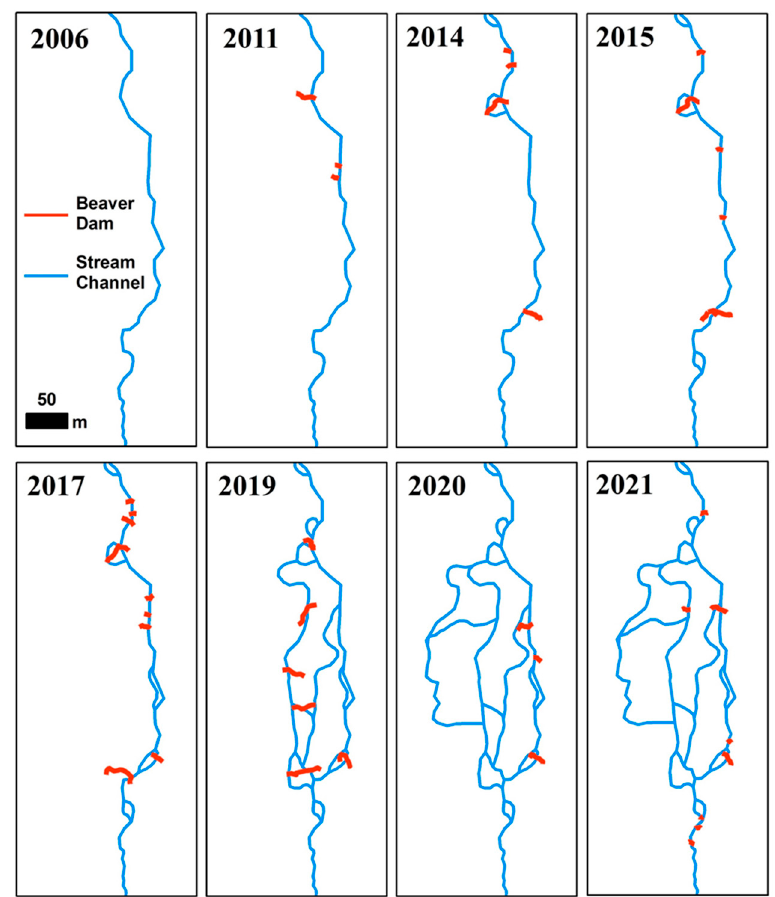
Figure 7. Delineation of beaver dams and stream channels along the study section of Swan Lake Creek between 2006 and 2021 that were digitized in VHRS imagery. Beavers began establishing dams in the study area between 2006 and 2011. Between the decade from 2011 to 2021, dam numbers fluctuated with the peak occurring in 2017 ( n = 9), prior to the failure of the dam system and development of the beaver-induced permafrost degradation between 2019 and 2020. Between 2006 and 2021, the length of the stream channel network increased from ~0.6 km to more than 1.9 km, or a 220% increase as a result of the combined effects of beaver engineering and permafrost